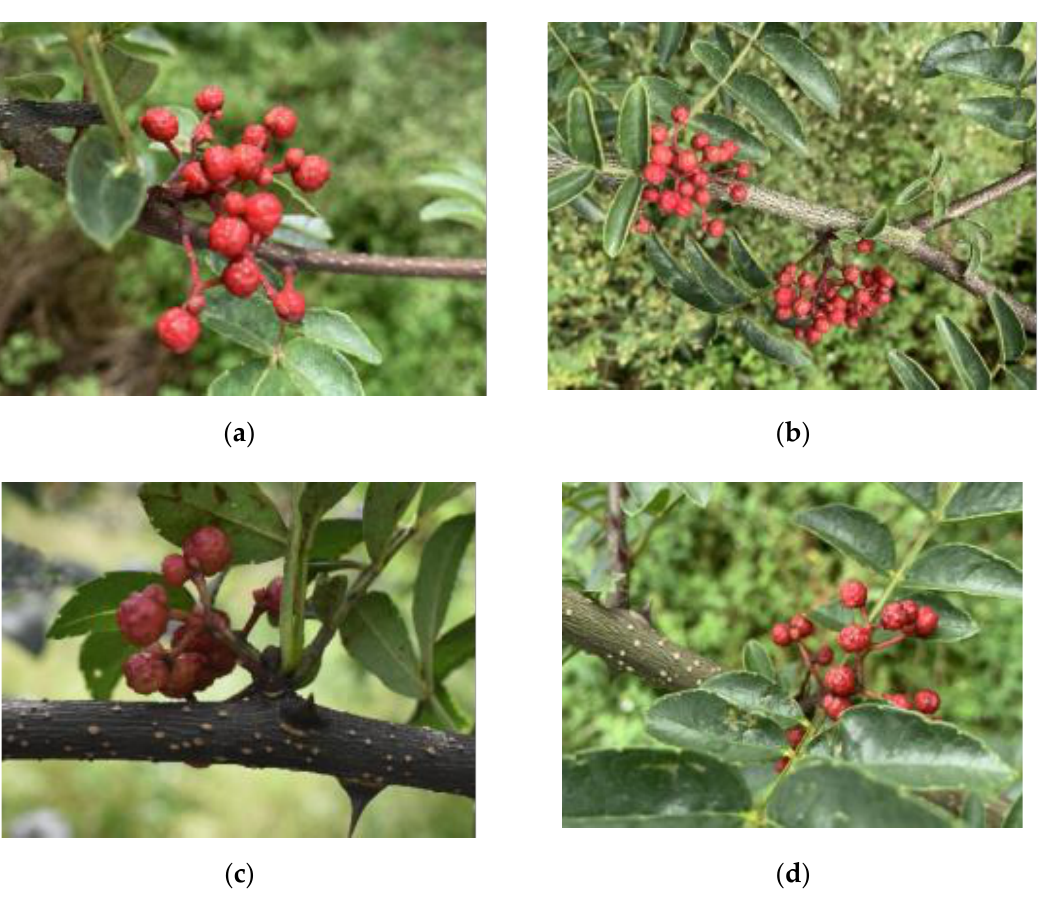
Figure 2. ( a ) Single front-lit cluster without occlusion; ( b ) multiple front-lit clusters without occlusion; ( c ) single back-lit cluster without occlusion; ( d ) single front-lit cluster and